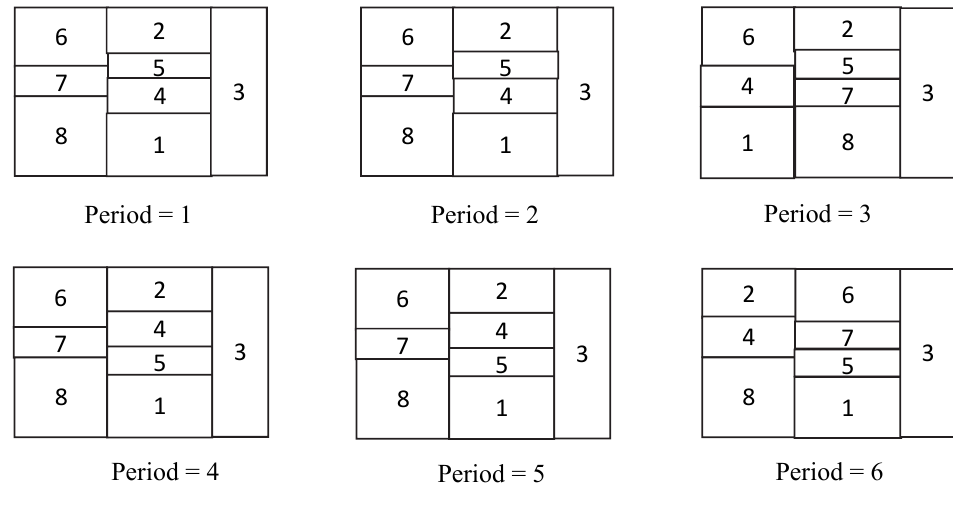
Fig. 8. (b) Best solution forFBS-DFLP-3, M = Fig. 8. Best layouts found for FBS-DFLP-3 with M = N and FBS-DFLP-3 with M = 3 problems